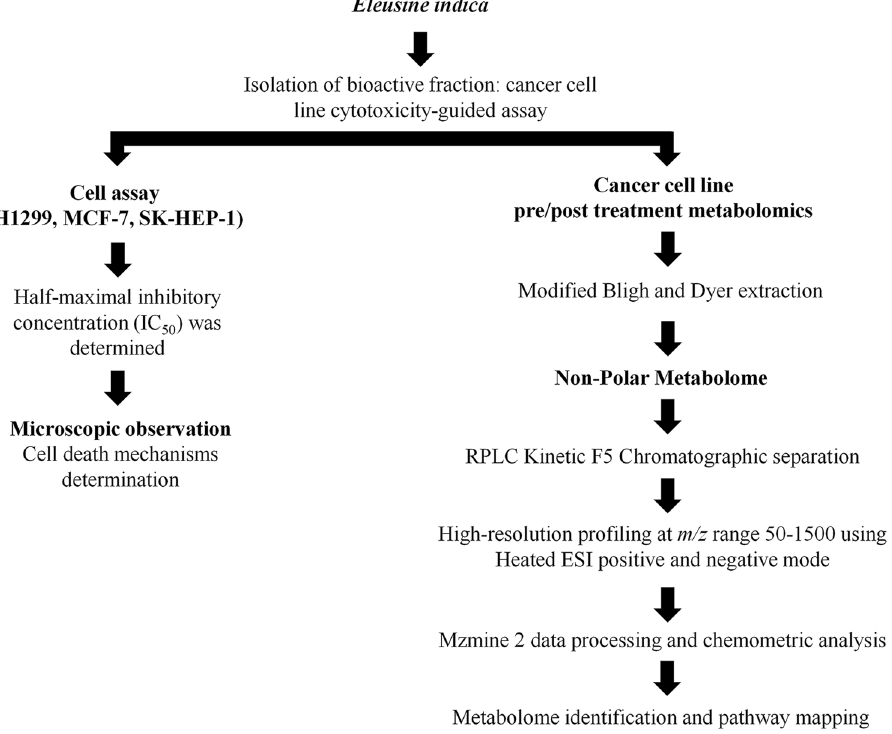
Figure 1. Overall experimental